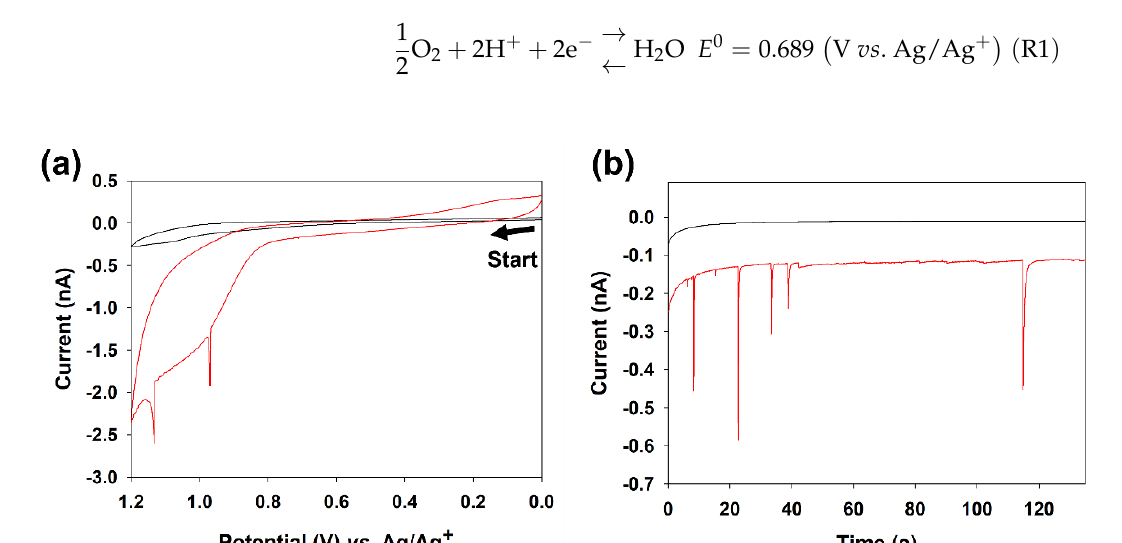
Figure 1. ( a ) CVs of the W/O emulsion droplets (0.1 M NaCl dissolved in aqueous phase) in pure DCE (black line) and in DCE containing 10 mM TBABF 4 (red line) on a Pt-UME at a scan rate 50 mV s − 1 . ( b ) Amperometric i-t curves of the W/O emulsion droplets (0.1 M NaCl dissolved in aqueous phase) in pure DCE (black line) and in DCE containing 10 mM TBABF 4 (red line) on a Pt-UME biased at 1.0 V (vs. Ag/Ag + ).